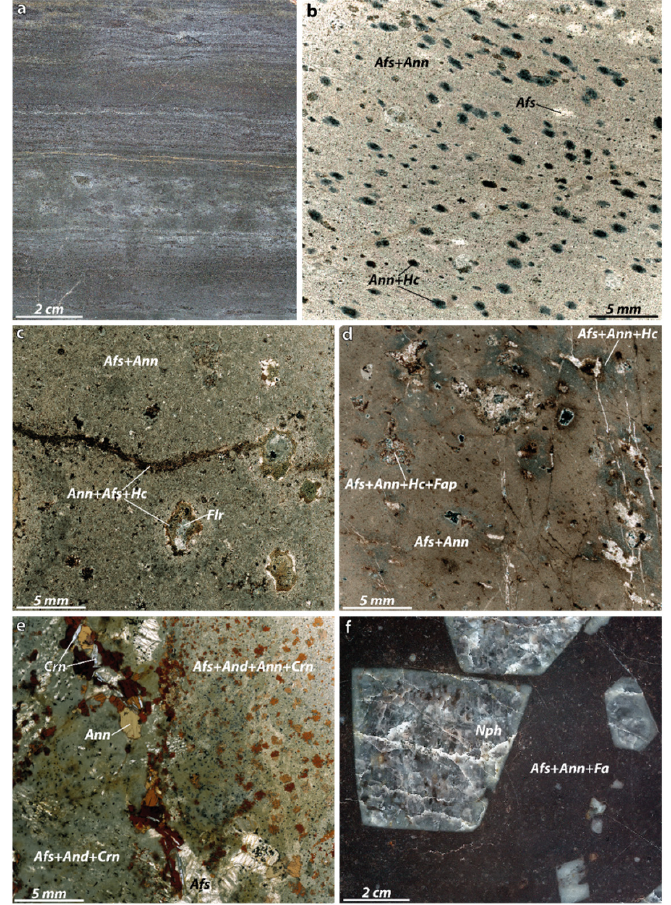
Figure 4. Typical textures of aluminous hornfelses. ( a ) hornfels with banded texture (sample KH-61-3); light- and dark-colored bands are due to the increased content of feldspar and annite + fayalite, respec- tively; ( b ) hornfels with spotty texture (sample E-97-33); dark spots are annite + hercynite segrega- tions and light spots are feldspar; ( c ) hornfels with zoned (fluorite in the center and annite + hercynite at the rim) segregations and thin annite-rich veins (sample LV-160/4); ( d ) hornfels with light- and dark-colored segregations connected by numerous feldspar veinlets (sample LV-121A); ( e ) vein- let composed of feldspar, annite, and corundum in corundum-andalusite-annite-feldspar horn- fels (sample KCH-05-15); ( f ) large poikilitic nepheline crystals in fayalite-annite-feldspar hornfels (sample KH-31-1). ( a , f )–photos of the polished samples surfaces; ( b – e )–photos of thin sections in transmitted